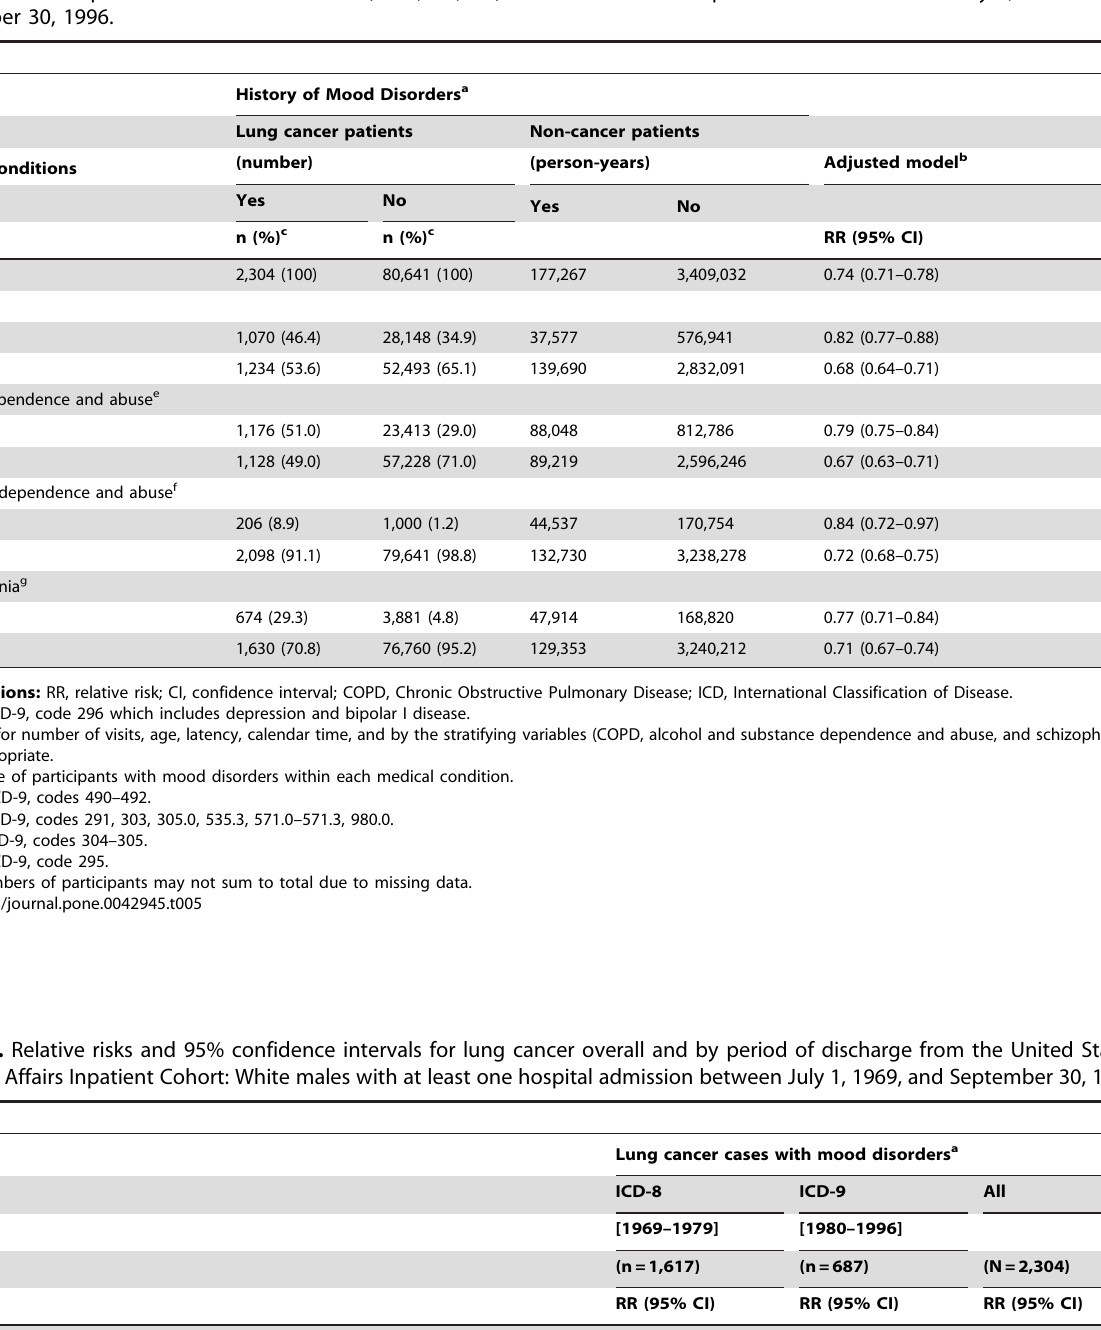
Table 5. Relative risks and 95% confidence intervals for lung cancer overall and by other medical conditions in the United States Veterans Affairs Inpatient Cohort: White males (n= 3,669,224) with at least one hospital admission between July 1, 1969 and September 30, 1996.